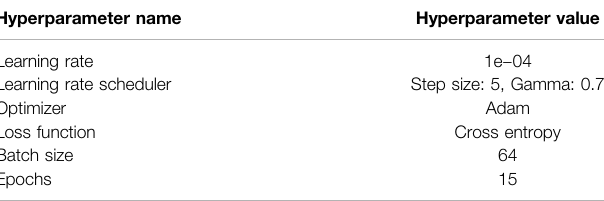
TABLE 2 | Hyperparameters used to trained the ResNet-18 classi fi